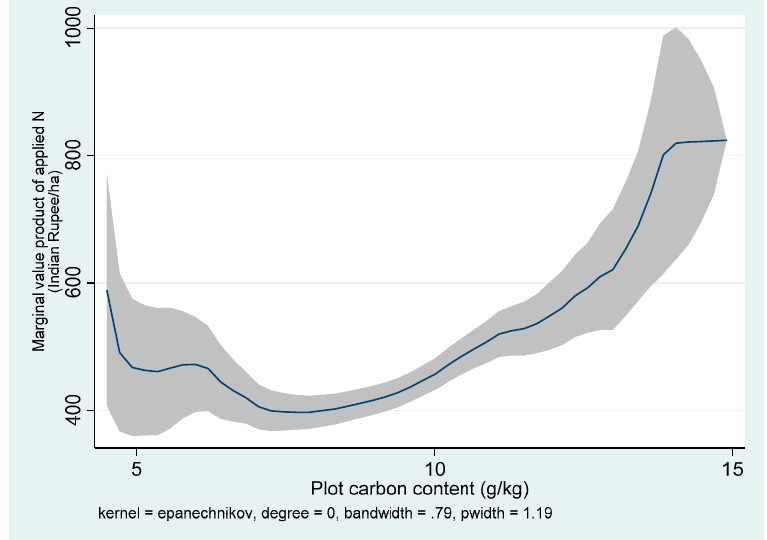
Figure 13. Marginal value product of N ( MVP N ) based on the plot’s carbon content in Aduthurai, India.